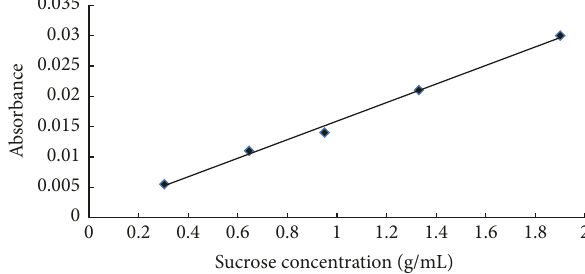
Figure 2: Calibration curve for the spectrophotometer.